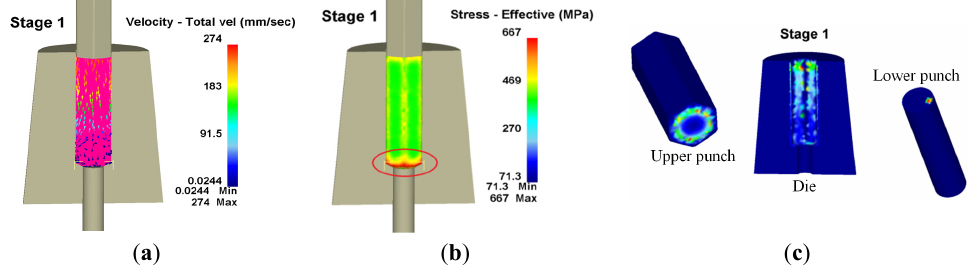
Figure 9. Velocity, effective stress and wear distribution of the first stage in 3D. ( a ) Velocity; ( b ) Effective stress; ( c ) Wear.